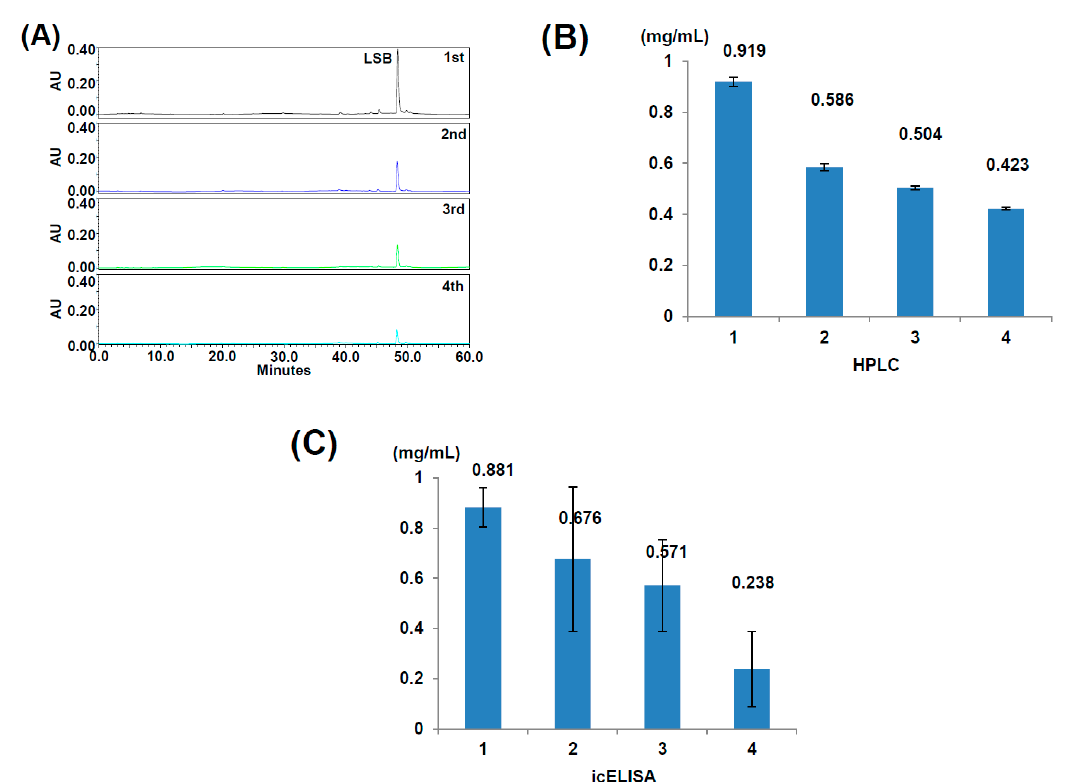
Figure 5. Detection of LSB contents in Danshen extracts by HPLC and indirect competitive ELISA (icELISA). Danshen of 1 g was successively extracted with 20 mL of 20% ethanol for four times, and the four extracts were analyzed by HPLC ( A ). The contents of LSB in the four extracts shown in HPLC were quantitatively measured ( n = 3) ( B ). The four extracts were diluted by 1000 times and quantitatively measured by icELISA ( n = 3) ( C ).